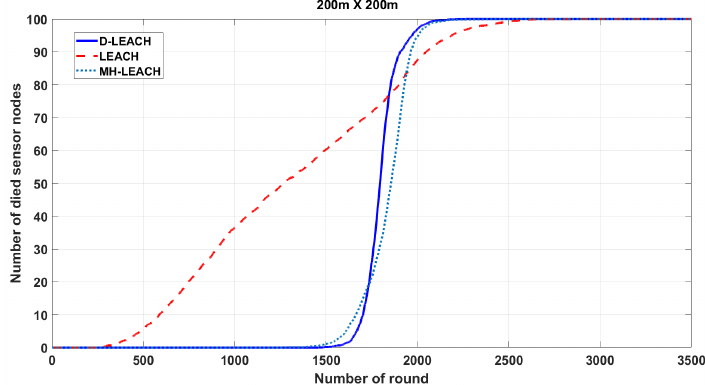
Figure 14. The number of dead sensor nodes in WSNs (200 × 200 m 2